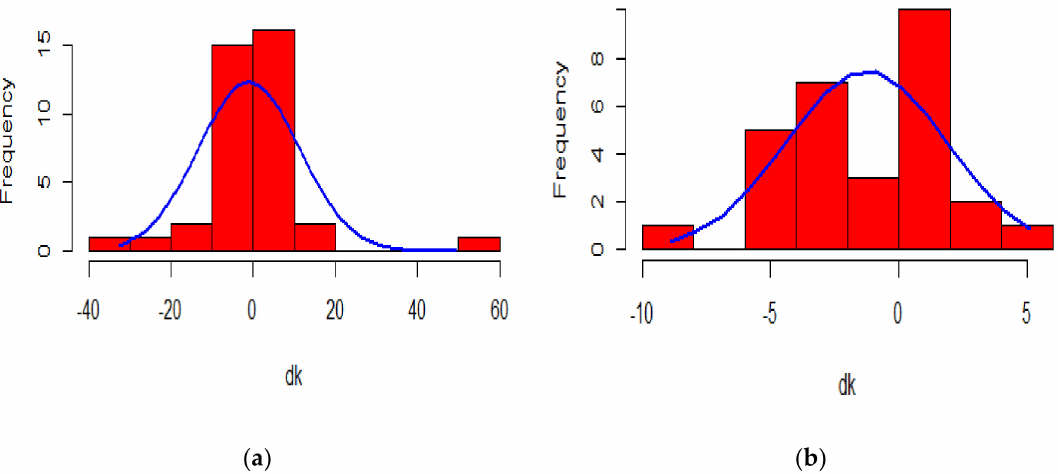
Figure 17. Comparison between a normal probability curve and the shape distribution of the change in the Lee-Carter mortality index for ( a ) 1900–1938 period, and ( b ) 1961–1990 period. The maximum likelihood estimates of the Kou model for the 1900–1938 period are θ = (cid:0) (cid:1) = (cid:0) (cid:1) µ , σ 2 , λ u , λ d , η u , η d 64.3462, 50.0392 2 , 49.7899, 43.2786, 50.4527, 50.4527 . All the estimates are statistically significant at a level of 5%. The value of the likelihood function is − 47073.237478. From the estimated parameters, it can be deduced that λ = 93.0685. The parameter estimates of the 1961–1990 (cid:0) (cid:1) = (cid:0) (cid:1) µ , σ 2 , λ u , λ d , η u , η d period are 93.5987, 50.0406 2 , 49.6722, 43.0902, 61.5849, 50.1861 . Due to the extreme events occurring from the outbreak of Spanish influenza in 1918 and from the First World War, the Kou model predicts sudden jumps in mortality for the 1939–1960 period. The Kou model also predicts jumps for the 1991–2015 period, however, the absence of outliers during this period of time might result in underperformance from the Kou